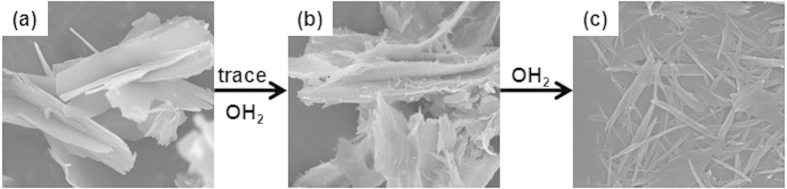
Substitution of ligands in the [Co(C2O4)(EG)] complex.(a) nanosheet-shaped [Co(C2O4)(EG)], (b) nanorod-shaped [Co(C2O4)(EG)x(OH2)y], and (c) nanorod-shaped [Co(C2O4)(OH2)2].